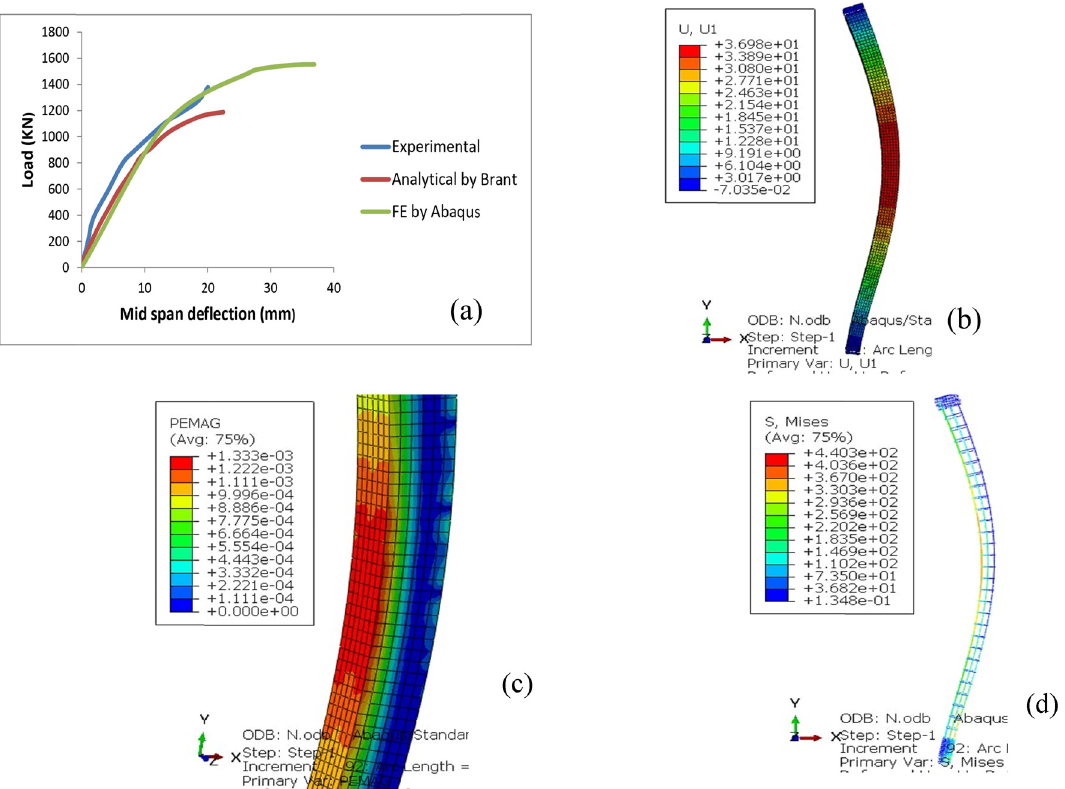
Figure 9: ( a ) Load – de fl ection relationship of Model No. 2, ( b ) de fl ected shape, ( c ) plastic strains in concrete, and ( d ) stress in steel reinforcement.